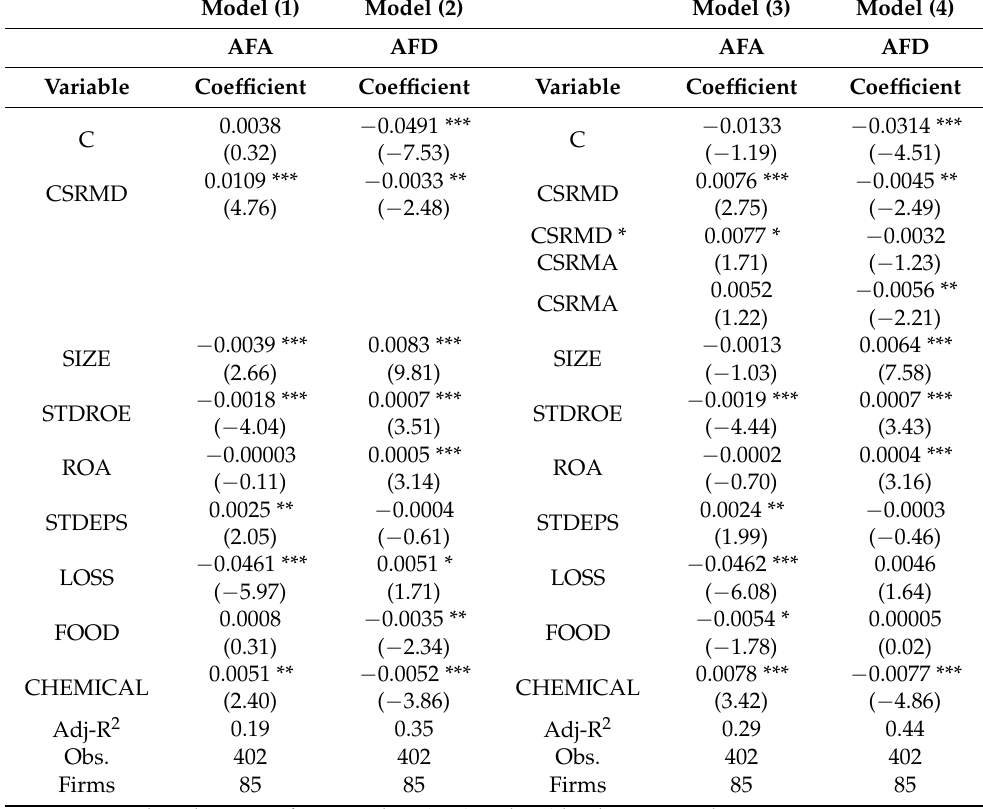
Table 4. Empirical